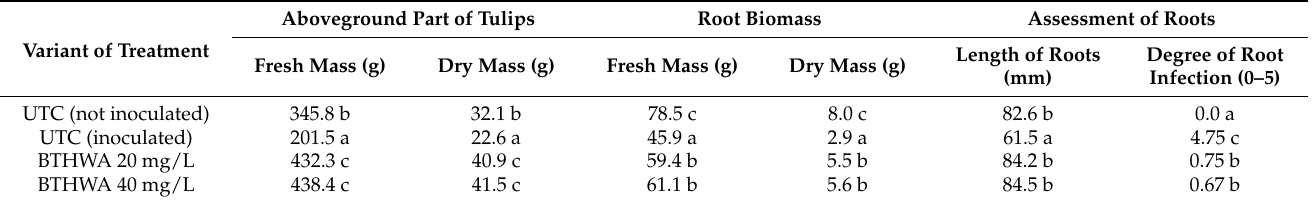
Table 3. Influence of tested variants of treatment on the fresh and dry mass of the aboveground part of tulips and roots and on the length of roots and degree of root infection.